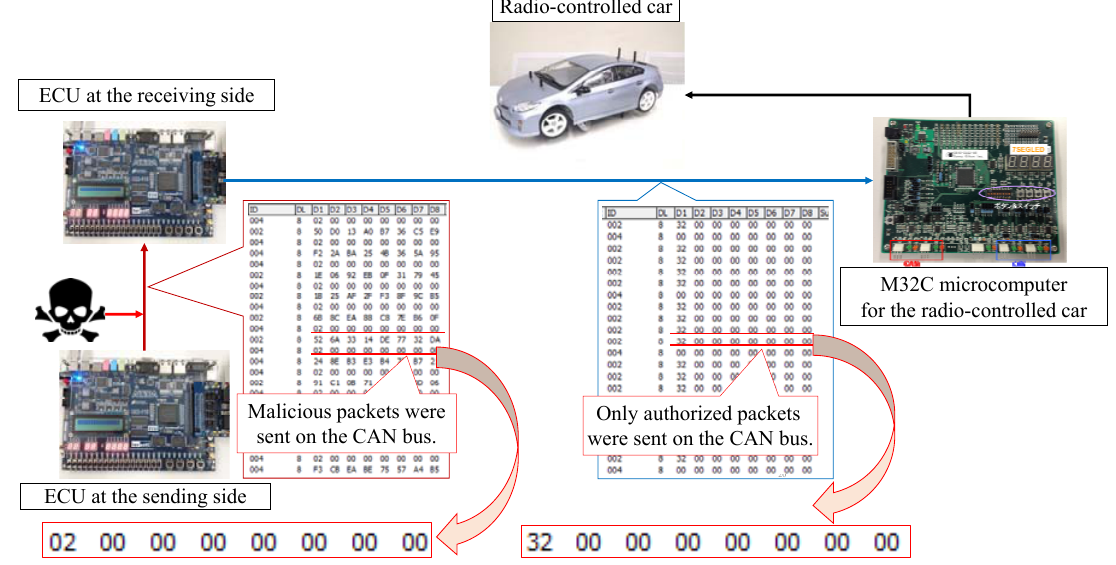
Fig. 10. Observed data (Proposed CAN communications with